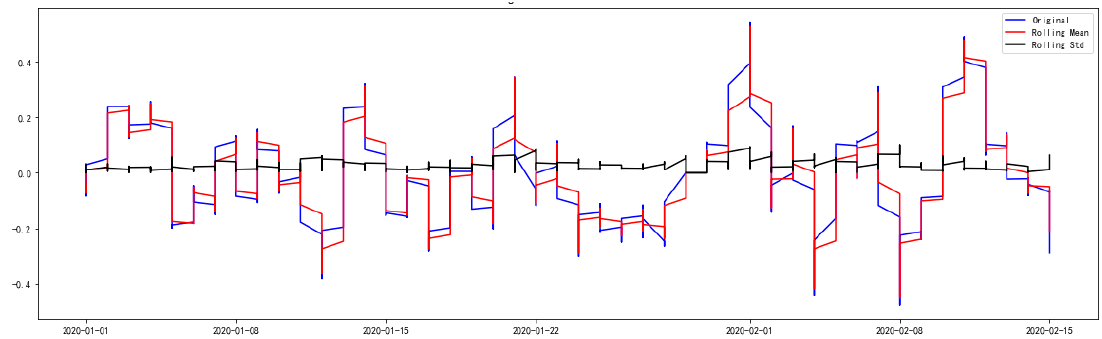
Figure 2. The rolling mean and rolling standard deviation of NO 2 concentration datasets.